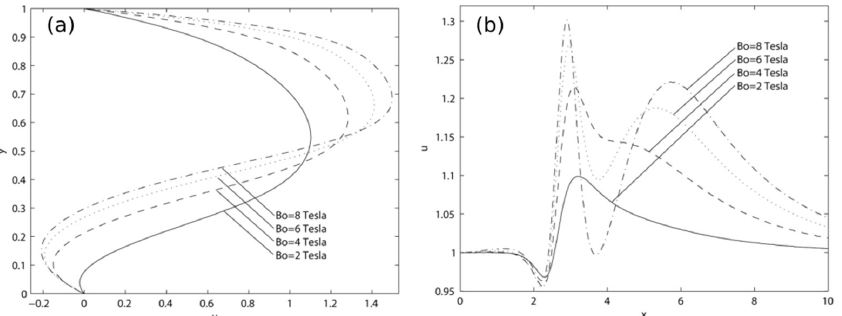
Figure 4. Axial velocity profiles at ( a ) x = 3.5; and ( b ) mid-span of the channel when subjected to various magnetic field strengths with Re = 250.